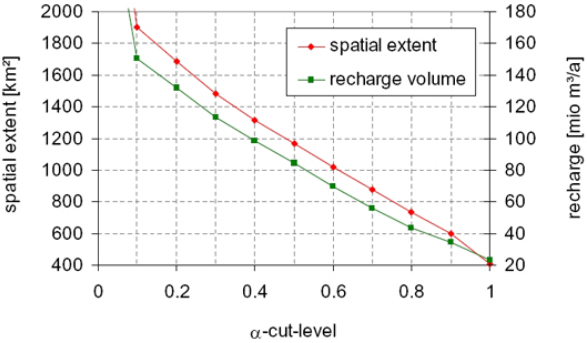
Fig. 8. Results (extent and recharge volume) for the Maawil plume.